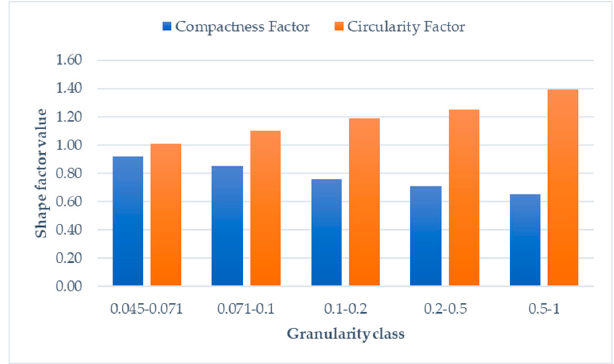
Figure 11. The F H and Fc factor for separated granularities of copper ore.